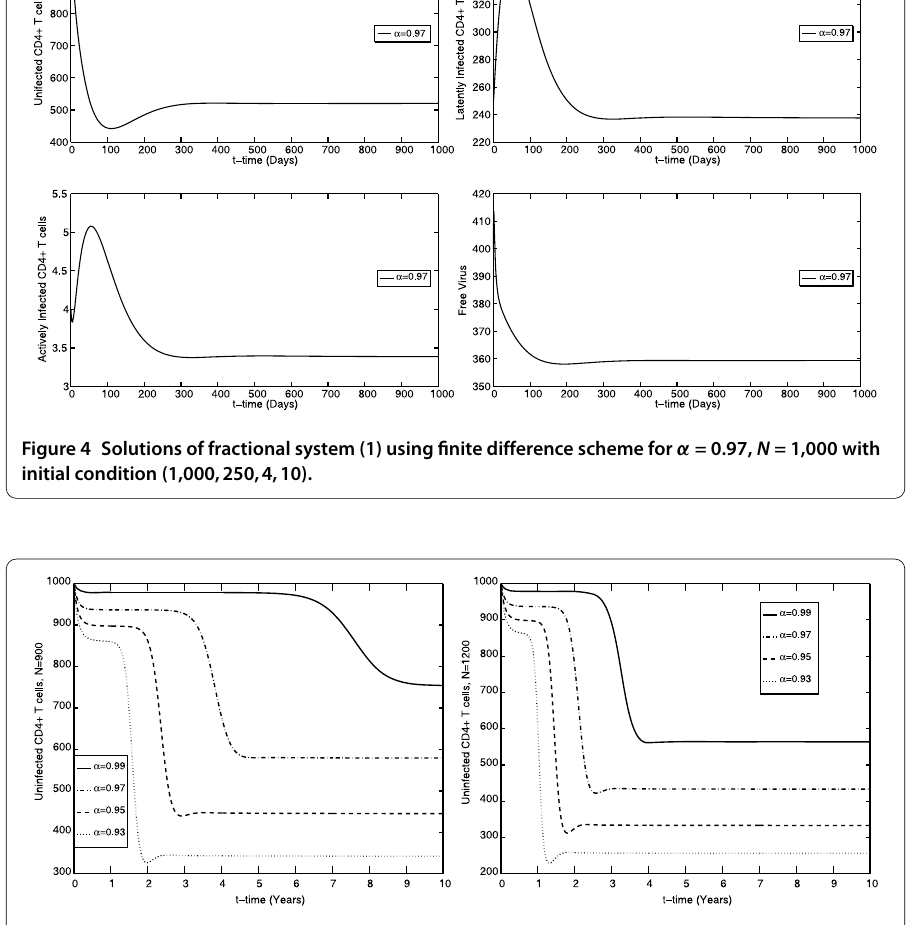
Figure 5 Effect of fractional derivative on T-cell depletion for N = 900,1,200 other parameters are given in Table 1 with initial condition